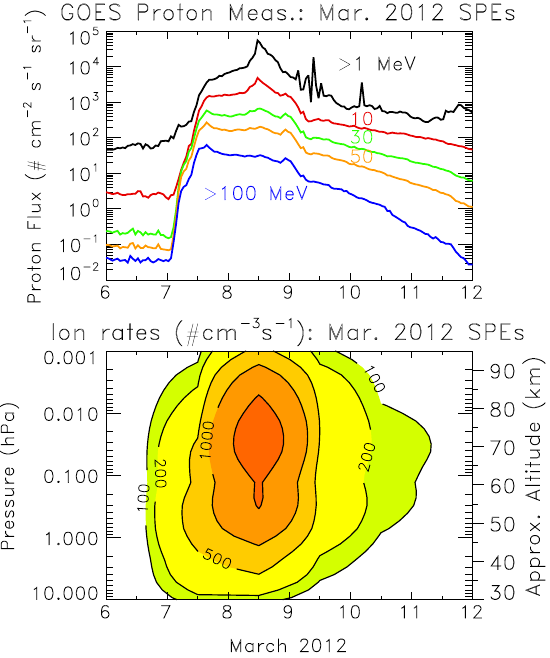
Fig. 2. ( Top ) GOES 13 proton flux measurements in March 2012 for energies >1MeV (black), >10MeV (red), >30MeV (green), >50MeV (gold), and >100MeV (blue). These data are provided by the NOAA SWPC at their website (see Sect. 2). ( Bottom ) Daily averaged ionization rates over the 10 to 0.001hPa pressure range for the 6–11 March 2012 time period. Contour intervals are 100, 200, 500, 1000, and 2000 (#cm − 3 s − 1 )